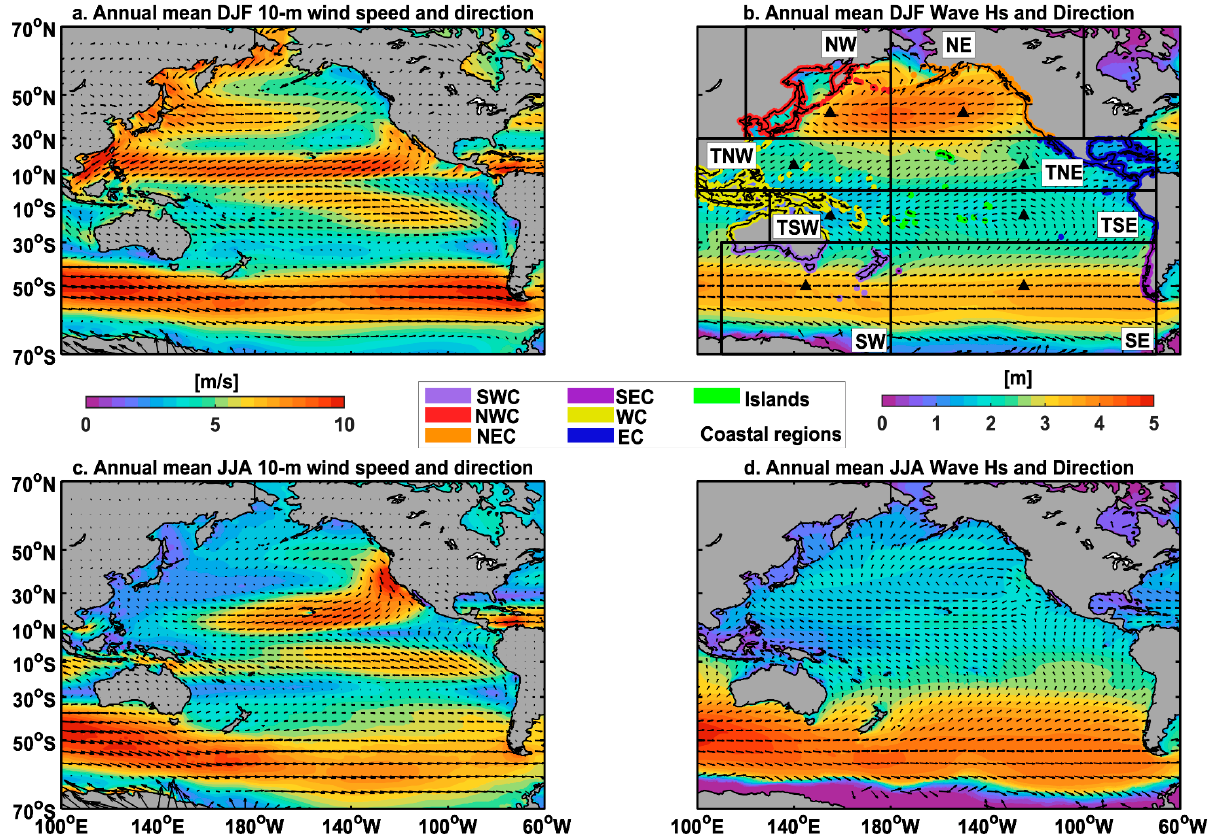
Figure 1. Climatology of 10 meters wind speeds (shading) and direction (arrows) ( a ) and of significant wave height (shading) and direction (arrows) ( b ) averaged in boreal winter (December–February, DJF) over the period 1979–2020. Panels ( c ) and ( d ) are the same but averaged in boreal summer (June–August, JJA). Delineations of open-ocean wave generation (black boxes) and coastal regions (colored dots) in the Pacific are shown in panel ( b ). The centroid of each open-ocean region, evaluated as the spatial barycenter of the region considering only oceanic points and represented by the black triangles in panel ( b ), displays the spatial origin of all extreme events occurring in this region.